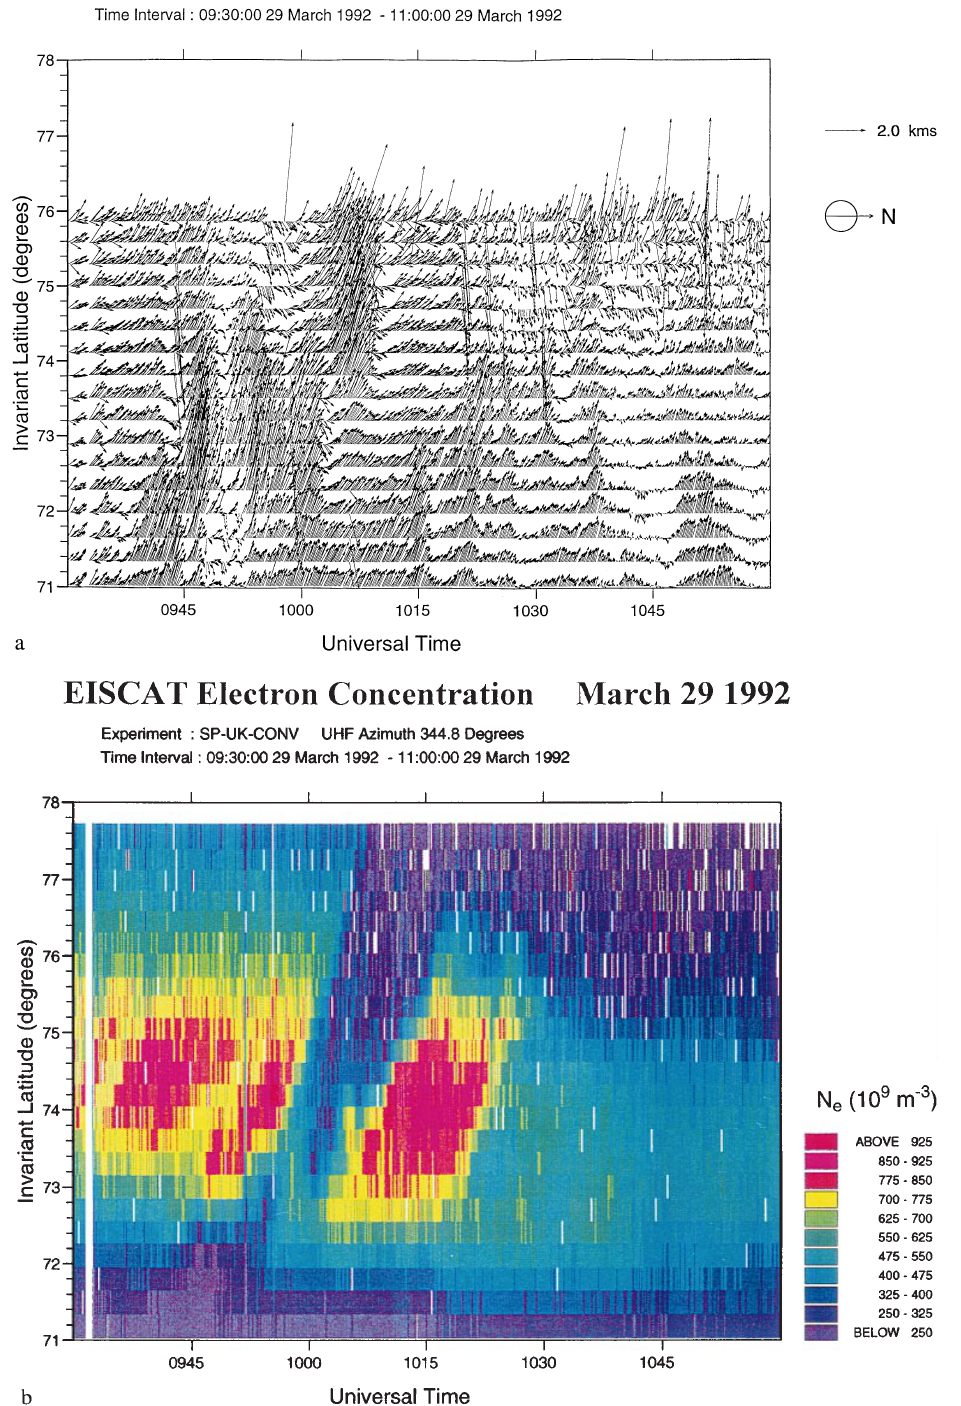
Fig. 1a, b. EISCAT data for 29 March, 1992. a Ion velocity vectors; b electron